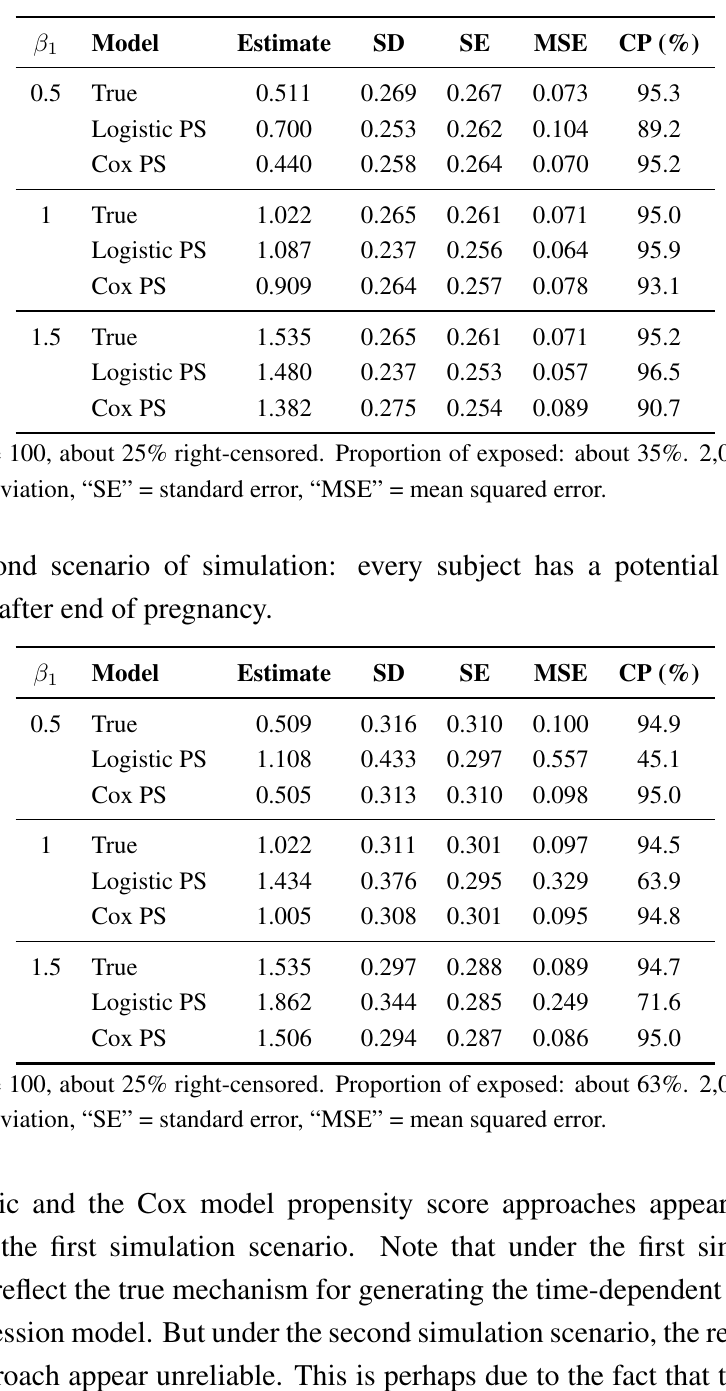
Table 1. First scenario of simulation: intermediate exposure status generated as binary, then timing of exposure is generated. β 1 Model